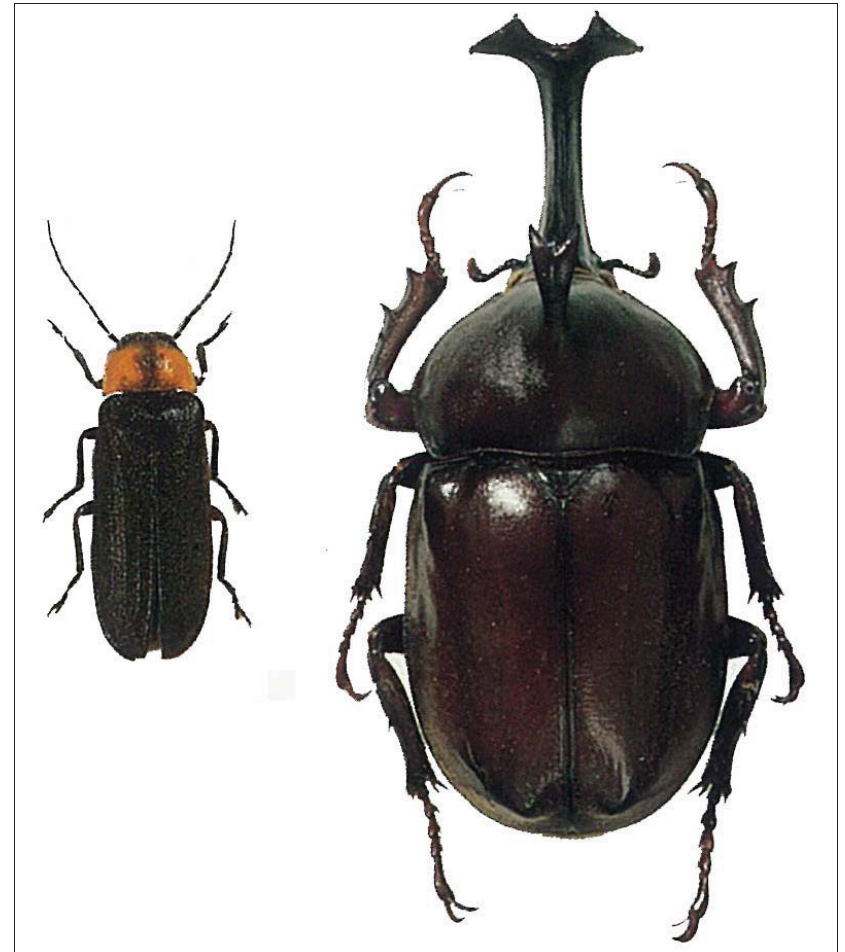
Figure 1. The common lampyrid species of Genji-fireflies ( Luciola cruciata Motschulsky) (10–16 mm in length) and male of Japanese rhinoceros beetle [ Allomyrina dichotoma (Linne)] (32–53 mm in length). These figures are cited from Sato [21] and Kurosawa et al . [22], respectively (in The Coleoptera of Japan in Color published by